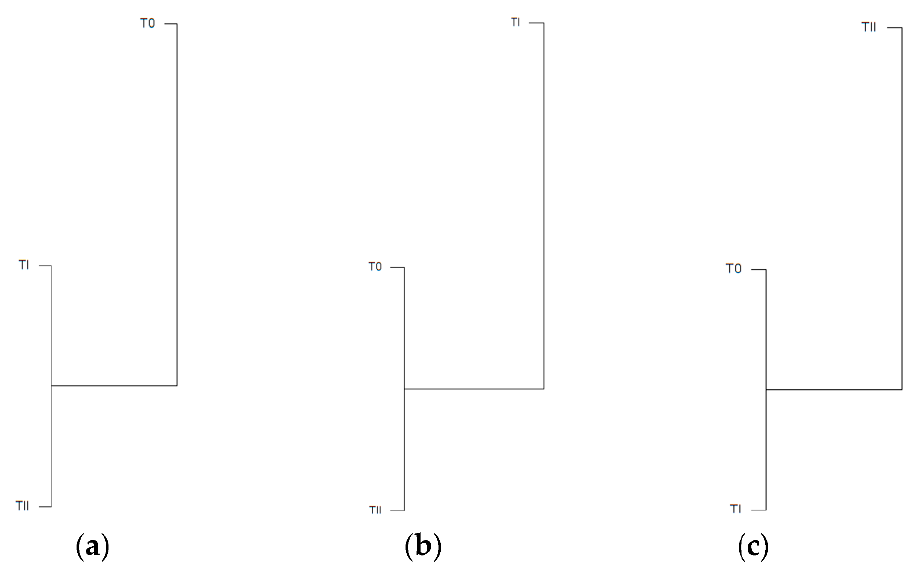
Figure 2. Dendrograms for Pb fractions in soil. Dendrogram ( a ) is suitable for Fr. 1 in the 2nd year and in the 3rd year, Fr. 3 in the 1st year and in the 2nd year, Fr. 4 in the 3rd year, Pb Tot in the 1st year and in the 2nd year, Pb DTPA in the 1st year and in the 3rd year. Dendrogram ( b ) is suitable for Fr. 2 in the 1st year and in the 2nd year, Fr. 4 in the 2nd year. Dendrogram ( c ) is suitable for Fr. 1 in the 1st year, Fr. 2 in the 3rd year, Fr. 3 in the 3rd year, Fr. 4 in the 1st year, Pb Tot in the 3rd year, Pb DTPA in the 2nd year.